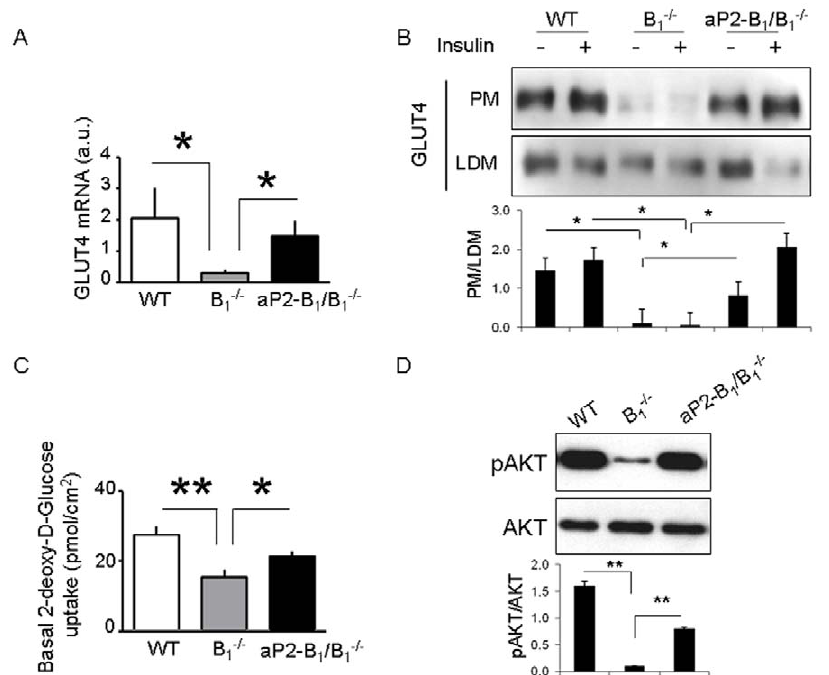
Figure 3. Rescue of kinin B 1 R expression in adipocytes of kinin B 1 R knockout mice (B 1 2 / 2 ) partially rescues GLUT4 expression and function in adipose tissue. A: Expression of GLUT4 mRNA in epididymal fat of random fed mice measured by realtime PCR. B: GLUT4 translocation in epididymal fat at basal states or after insulin stimulation (10 U intravenous bolus for 10 min). The blots and quantification are one representative experiment out of two performed independently. C: Basal glucose uptake in isolated adipocytes. [ 3 H]-2-deoxy-glucose accumulation was measured during 5 minutes. Data represent mean 6 SEM of six animals per group. D: Basal AKT phosphorylation in the epididymal fat of random fed mice. The blots and quantification are one representative experiment (pool of 4–5 mice each) out of two performed independently. *, P , 0.05; **, P , 0.001.